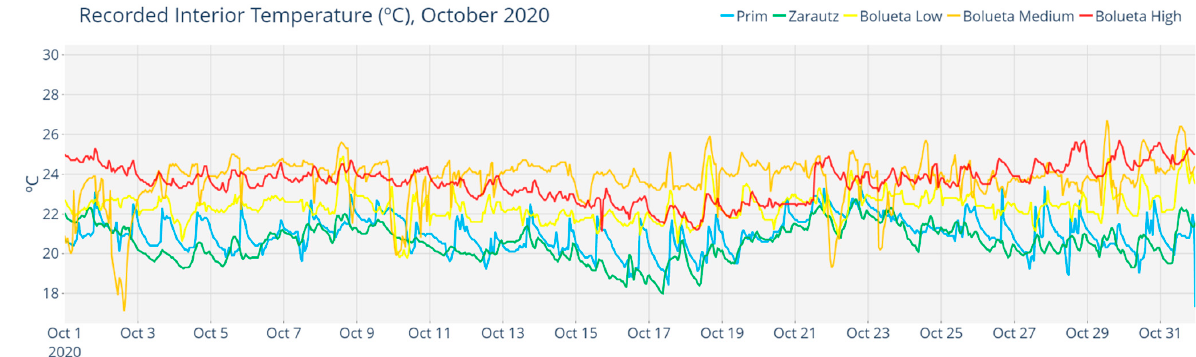
Figure 19. Recorded interior air temperature for all living rooms, October 2020. Source: authors.